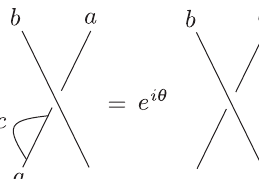
FIG. 10. Top panel: The simplest flux-tunable MZM braiding setup, following Refs. [42,43]. The black lines are nanowires hosting MZMs (red dots) at their end points. We tune the Josephson junctions ’ flux values j Φ between 0 and i j Φ Φ < 1 0 to change the strength of the Coulomb coupling 2 max between the MZM pairs γ and γ 0 . Bottom panel: Flux values at i i Φ the four turning points. When j Φ , Δ is maximized and i j ¼ i max γ is coupled to the center MZM γ 0 , formed out of a linear i combination of γ 0 1 , γ 0 2 , and γ 0 3